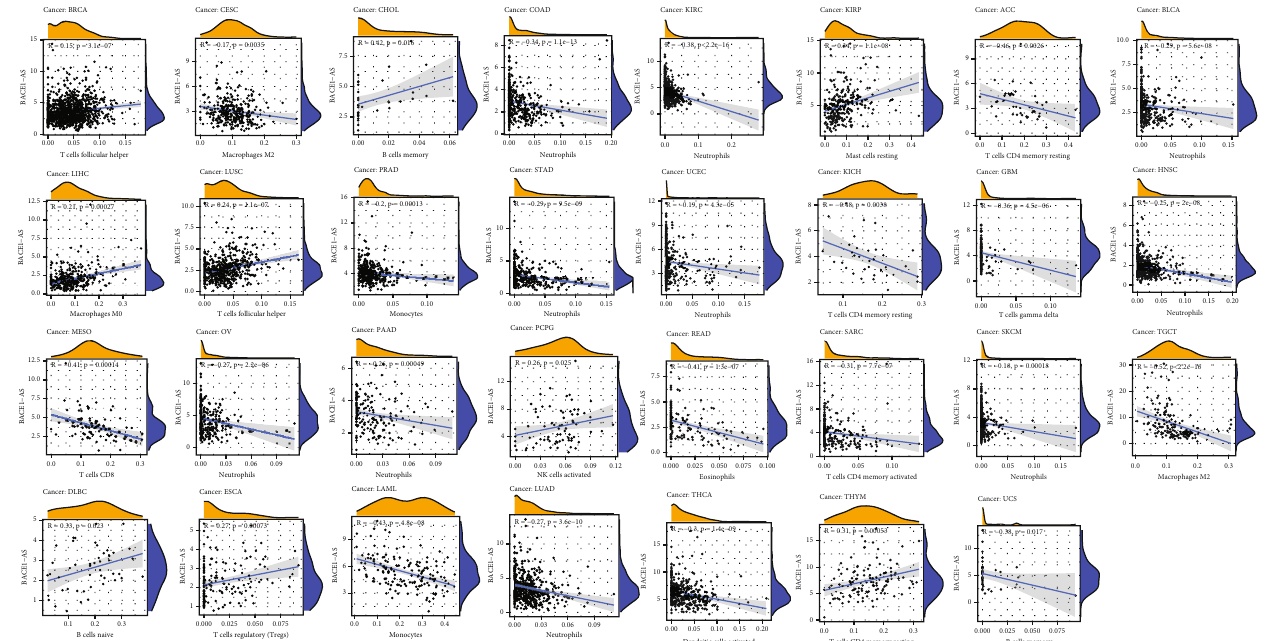
Figure 7: Correlation of BACE1-AS expression with immune cells in pan-cancer. Only the most closely related tumor in fi ltrating cells were exported in the fi